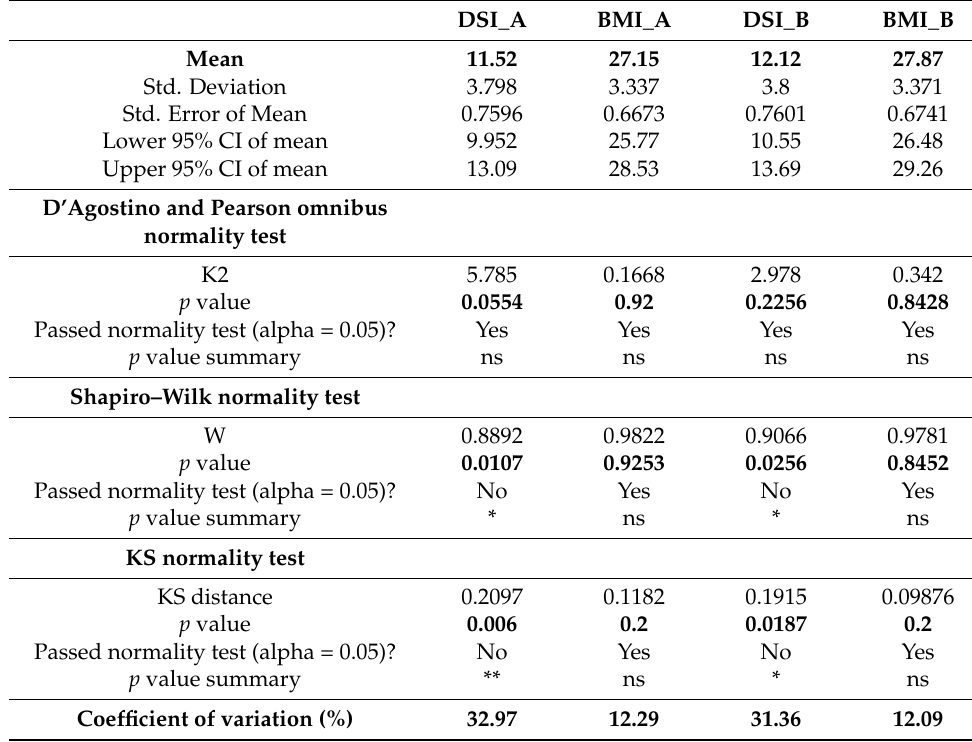
Table 2. Normality test results of DSI and of BMI for group A and group